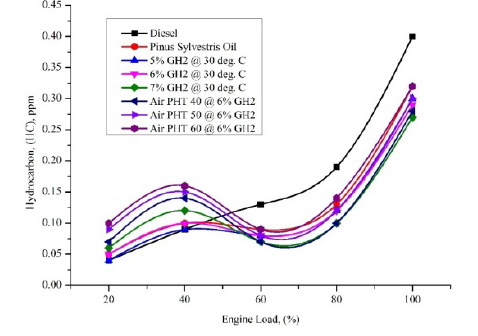
Figure 7. Co Vs. Engine Load At the maximum efficiency point with 6% GH energy share and 40 0 C, CO of 0.1 % by volume was registered, 0.03 % and 0.09% by volume reduced with